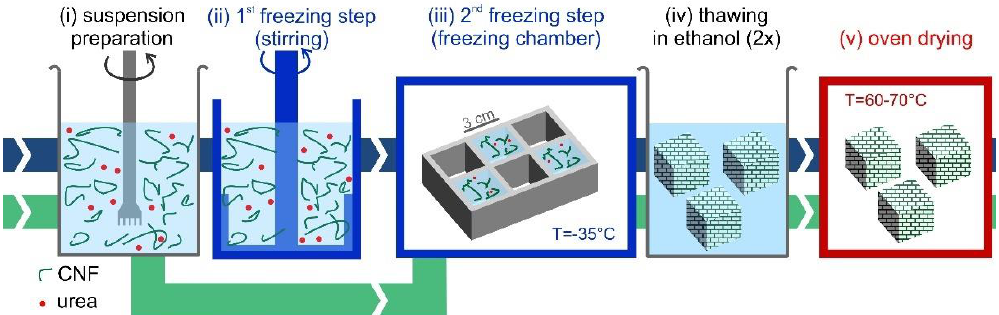
Figure 2. Schematic of the freezing-thawing-drying (FTD) foam fabrication process performed at environmental pressure. The stirred freezing process (blue path) consists of: ( i ) preparation and mixing of the Cellulose nanofibril (CNF) suspension in water with dissolved urea as an additive; ( ii ) first freezing step, inside an ice-cream machine, during which the suspension is partially frozen; ( iii ) second freezing step, during which sample freezing is completed in a silicone mold inside a freezer at − 35 °C; ( iv ) thawing and washing of the sample in ethanol; and ( v ) oven drying. For the static freezing process (green path), the first freezing step is skipped, and the CNF suspension is frozen directly in the freezing chamber.